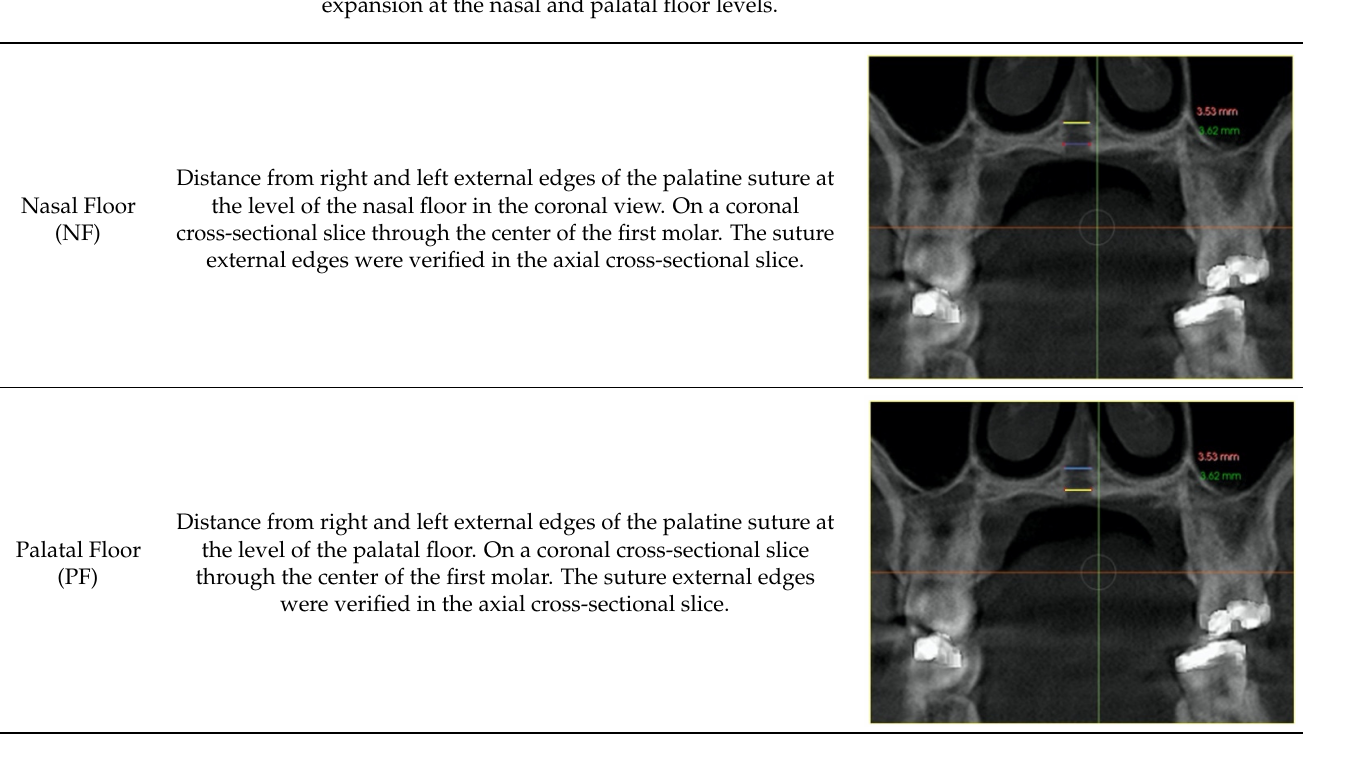
Table 3. Evaluation of the suture opening pattern in the coronal section and midpalatal suture expansion at the nasal and palatal floor